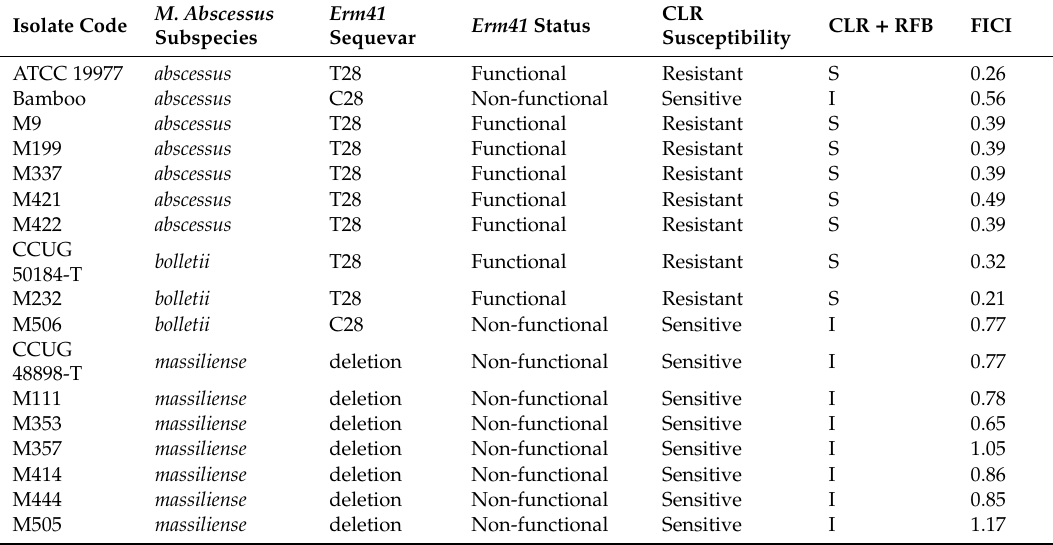
Table 1. Checkerboard assay results for the combination of clarithromycin and rifabutin against three reference strains and a collection of clinical isolates of M. abscessus